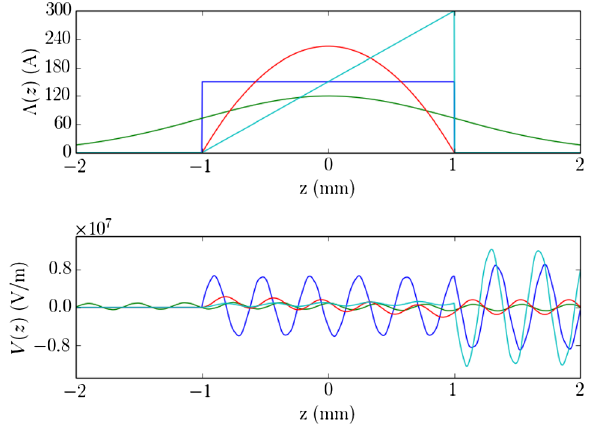
FIG. 2. Charge distributions (top) and corresponding wake potential (bottom) for the same structure parameters as shown in Fig. 1 and for a 1 nC Gaussian bunch with variance (Gaussian P m w distribution) or hard-edge half size (other distributions) of 1 mm. FIG. 1. Wake function computed as w z ð ζ Þ ¼ z;l for l ¼ 1 m ¼ 1 , 2, 4, 8, and 16 for a DLW structure with parameters The green, blue, red, and turquoise traces respectively correspond a ¼ 400 μ m, b ¼ 450 μ m, and ε 5 . 7 . The fundamental-mode to the case of a Gaussian, parabolic, uniform, and linearly ramped r ¼ current distributions. The head of the bunch is at z ≤ 0 (blue trace) wavelength is λ 1 ≃ 1 . 09 mm.